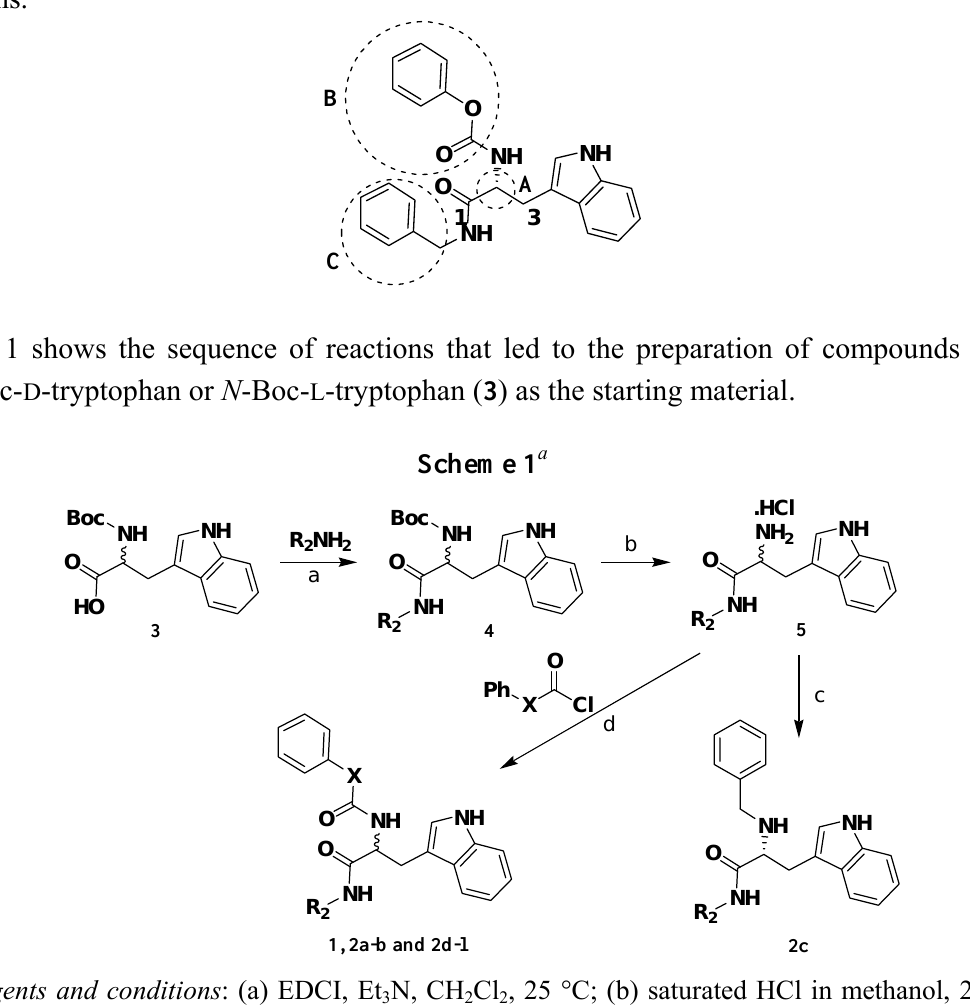
Figure 2. The structure of compound 1 and corresponding three structural modification regions.